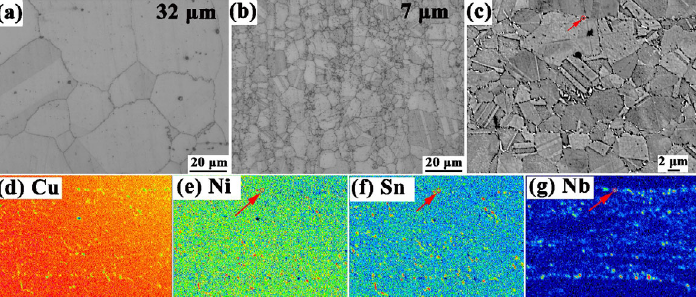
Fig. 3 Optical, SEM, and corresponding elemental mapping images of the alloys after solid solution treatment: optical images of (a) Cu–15Ni–8Sn and (b) Cu–15Ni–8Sn–0.8Nb alloys, (c) SEM and (d–g) corresponding elemental mapping images of Cu– 15Ni–8Sn–0.8Nb alloy.